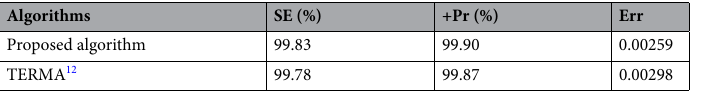
Table 1. Performance comparison of the R-peak detection for the 48 records of the MIT-BIH database.